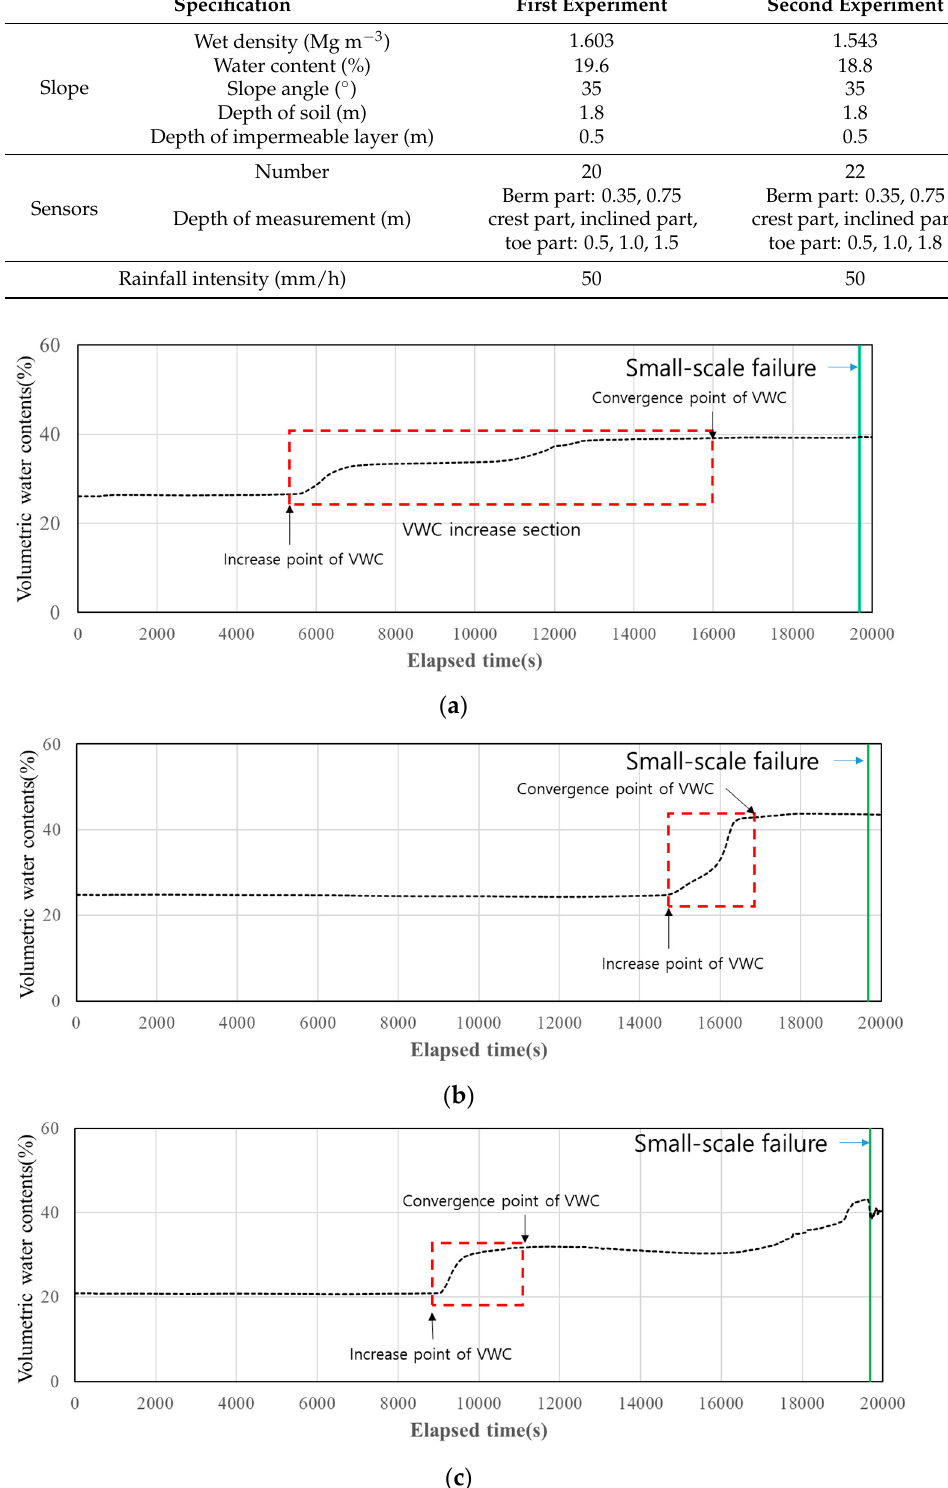
Figure 14. Variations of the VWC before small-scale failure in the flume experiments: ( a ) berm; ( b ) crest; and ( c ) inclined slope